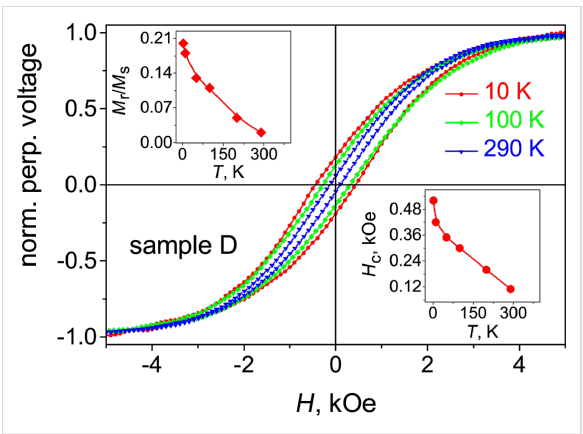
Figure 8: Isothermal Hall voltage cycling for sample D at a series of temperatures, as indicated. Insets: Temperature dependencies of the squareness M r / M s and the coercive field H c for sample D. The lines are guides for the